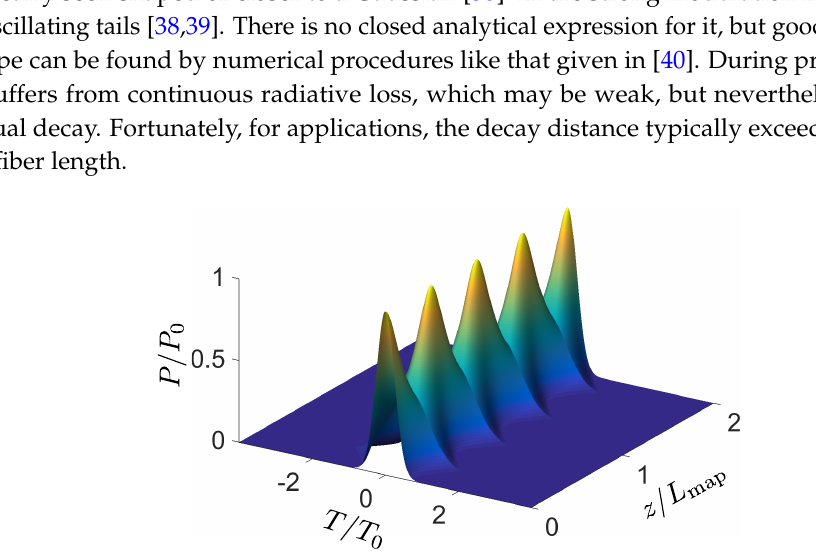
Figure 7. Evolution of a dispersion-managed soliton over two dispersion map